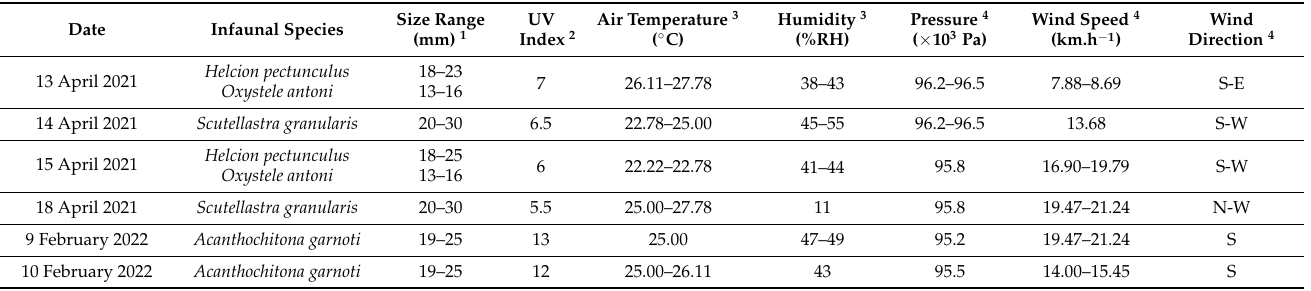
Table 1. Meteorological conditions for our series of experiments investigating temperature stress with the corresponding infaunal species